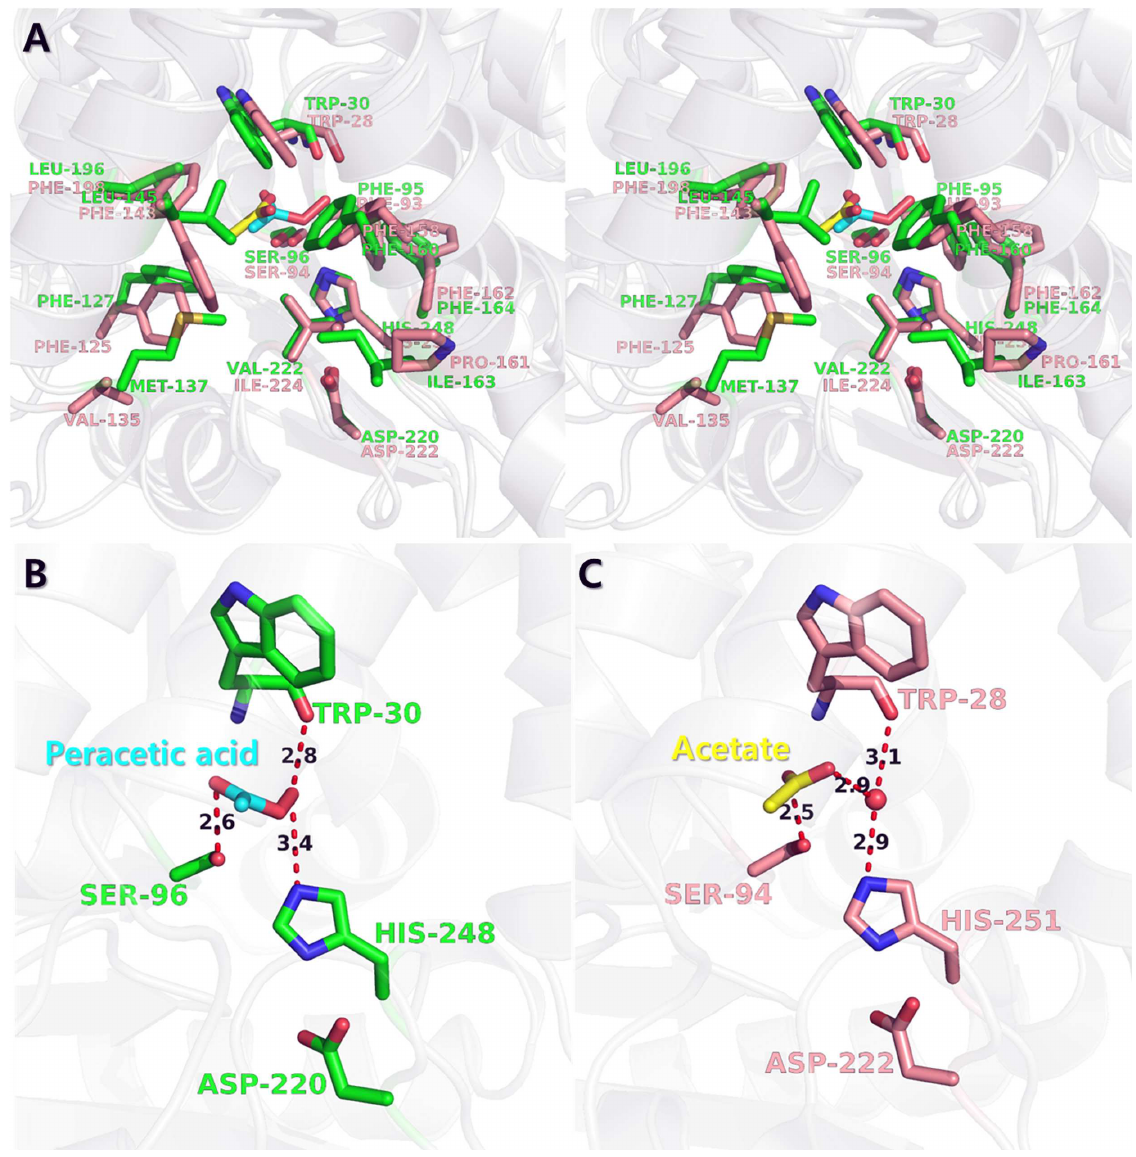
Fig 4. Structural comparisons of ligand-binding site between peracetate-bound Ea EST and acetate-bound Pf EST. (A) Stereo view of the superimposed structure of peracetate (cyan)-bound Ea EST (green)and acetate (yellow)-bound Pf EST (PDB code 3HI4, acetate-bound form, salmon). The residues comprisingthe active and ligand-bindingsites are shown in a stick representation. (B) Peracetate-bindingmode and its interactions in Ea EST structure. (C) Acetate-bindingmode and its interactions in Pf EST